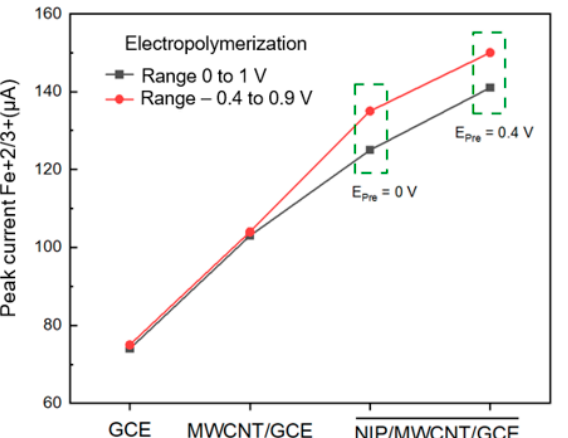
Figure 2. Comparison of current peaks Fe+2/+3 using GCE, MWCNT/GCE, and NIP/MWCNT/GCE sensor employed in the electropolymerization potential range of 0 to 1 V (black line) and − 0.4 to 0.9 V (red line).